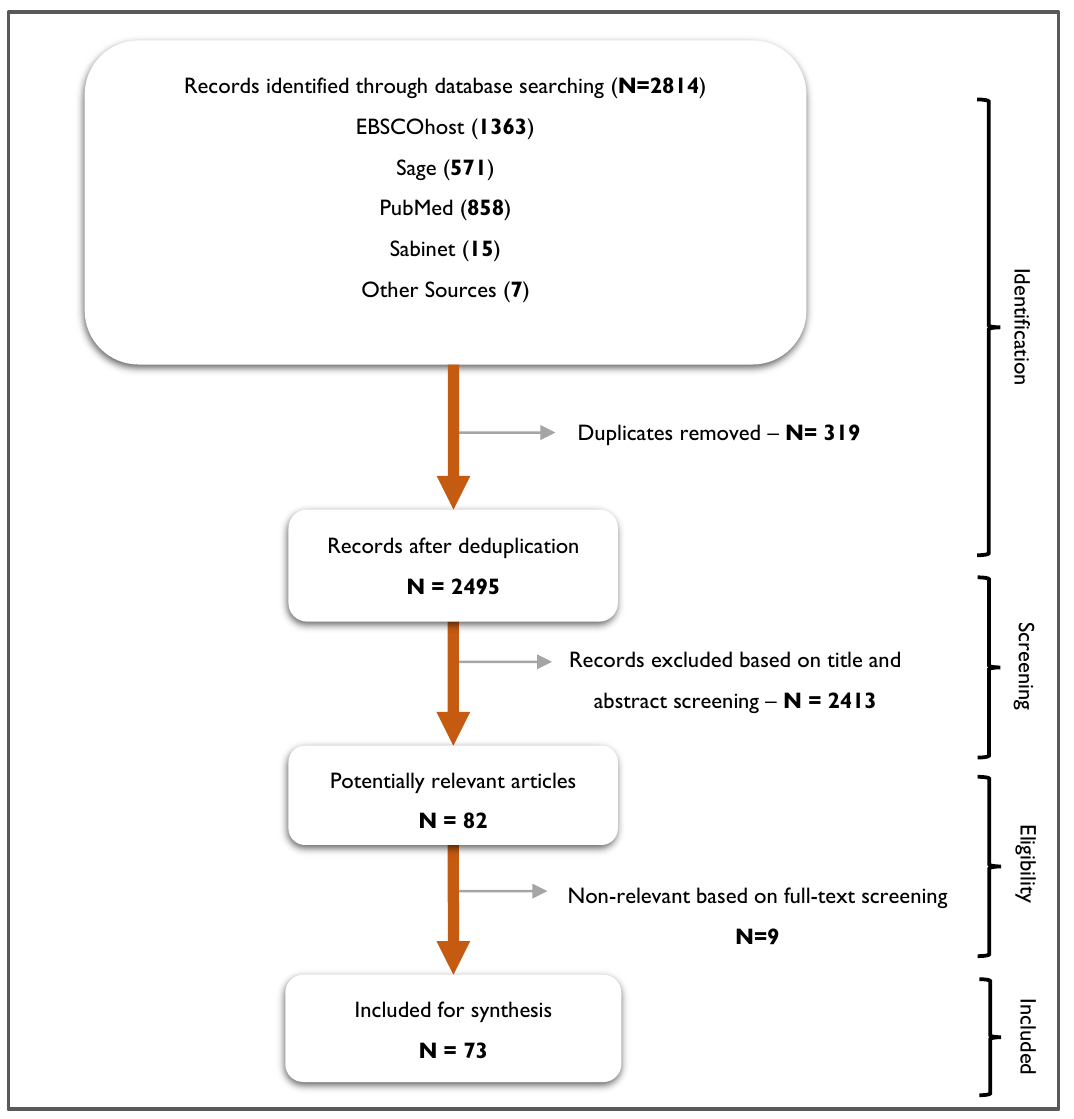
Figure 2. A flow chart for the selection process.